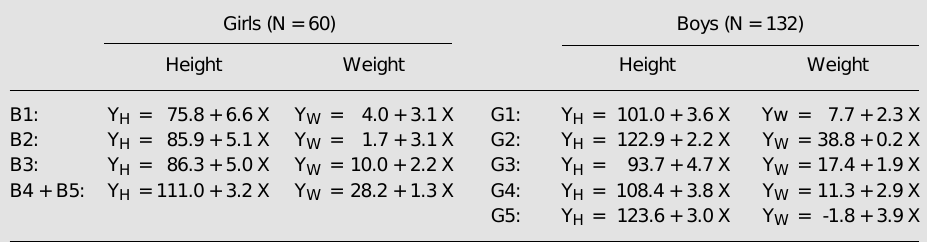
Table 1. Equations of height and weight adjustments to chronological age (years) at each sexual maturation stage of girls and boys of the present